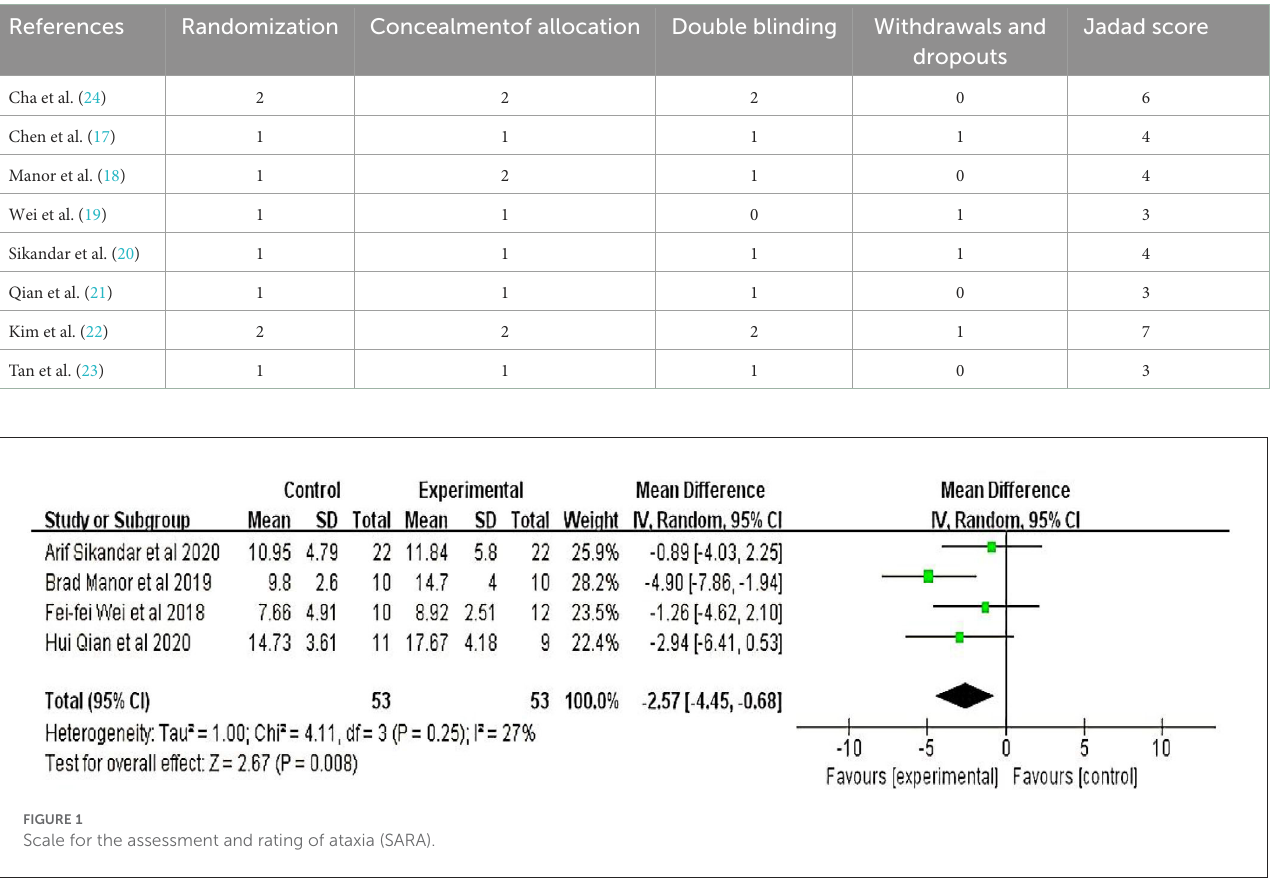
TABLE 2 Quality appraisal of the selected articles.